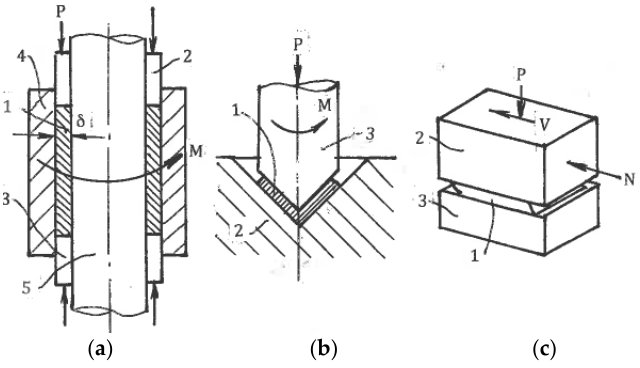
Figure 14. Friction SPD: ( a ) High-pressure tube twisting; ( b ) Cone-cone torsion; ( c ) High-pressure sliding.